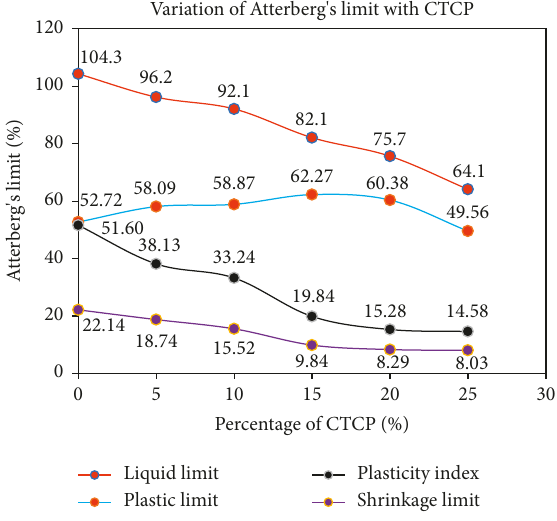
Figure 5: Effect of CTCP on Atterberg’s